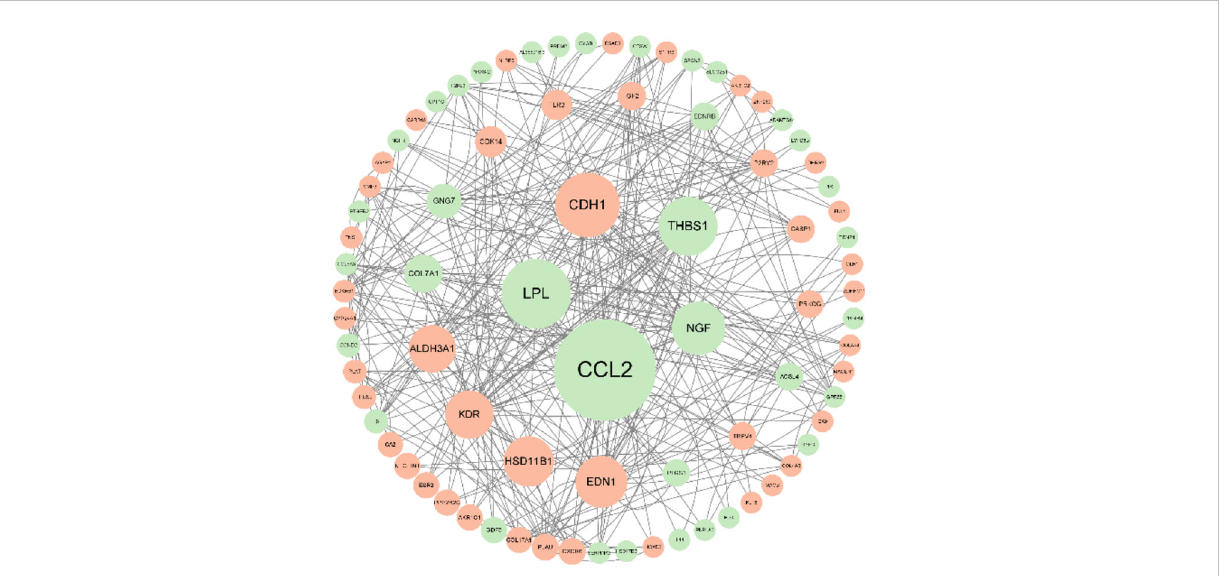
FIGURE 8 After knocking down SPON2, PPI network analysis of differential genes showed that CCL2, LPL, CDH1, THBS1, and NGF scored higher and were important key proteins. The larger the circle area, the higher the betweenness score; green represents the down-regulated genes and represents the up-regulated